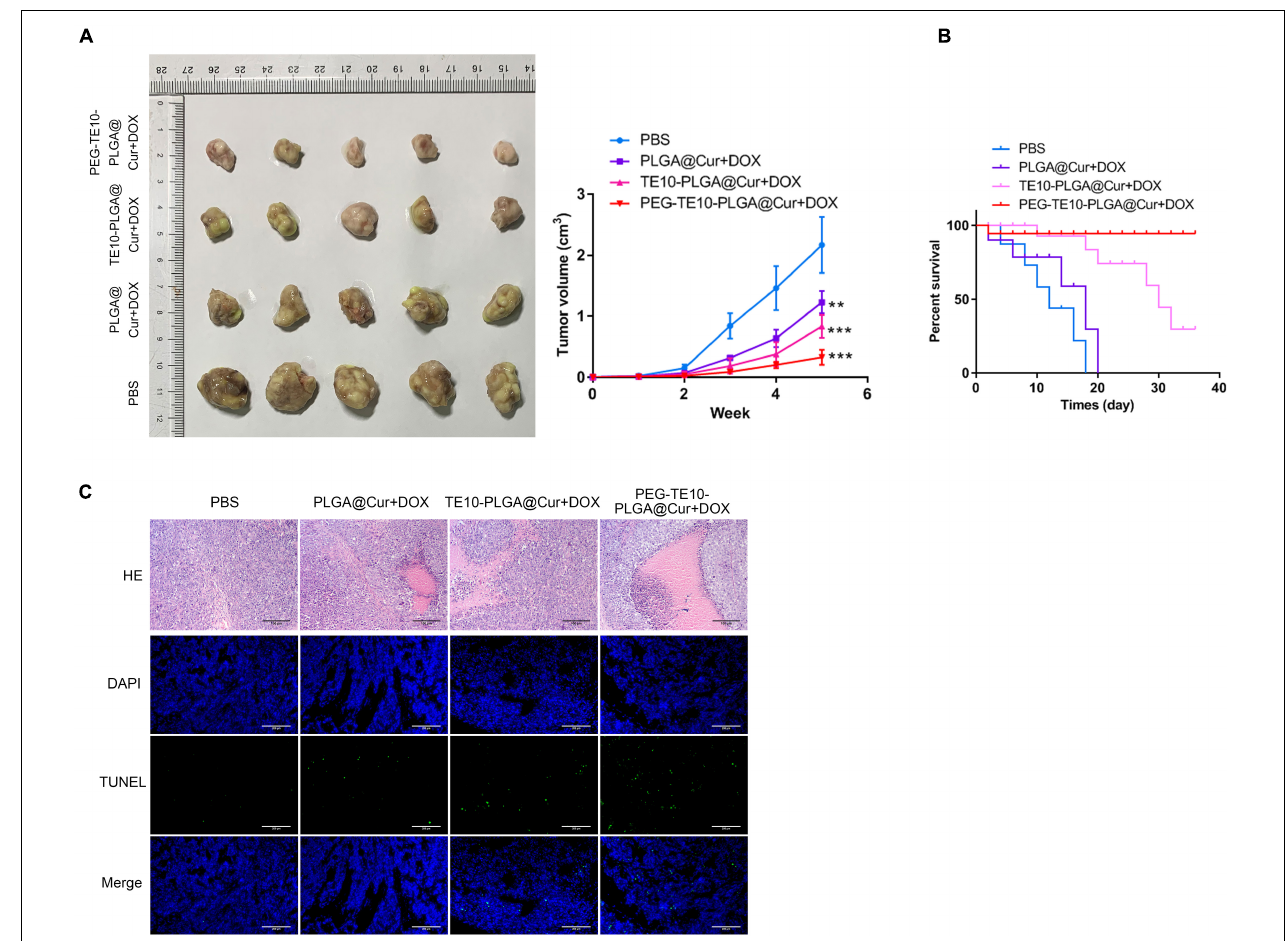
FIGURE 5 | In vivo anti-tumor activity of PMPNs. (A) Changes of tumor volume during the 16 days treatment of PMPNs. (B) The survival percent of mice treated with saline, PLGA@Cur + DOX, TE10-PLGA@Cur + DOX and PEG-TE10-PLGA@Cur + DOX during 40 days. (C) H&E and TUNEL staining of tumor tissue section of mice in the four groups. ** P < 0.01, *** P < 0.001 vs. control